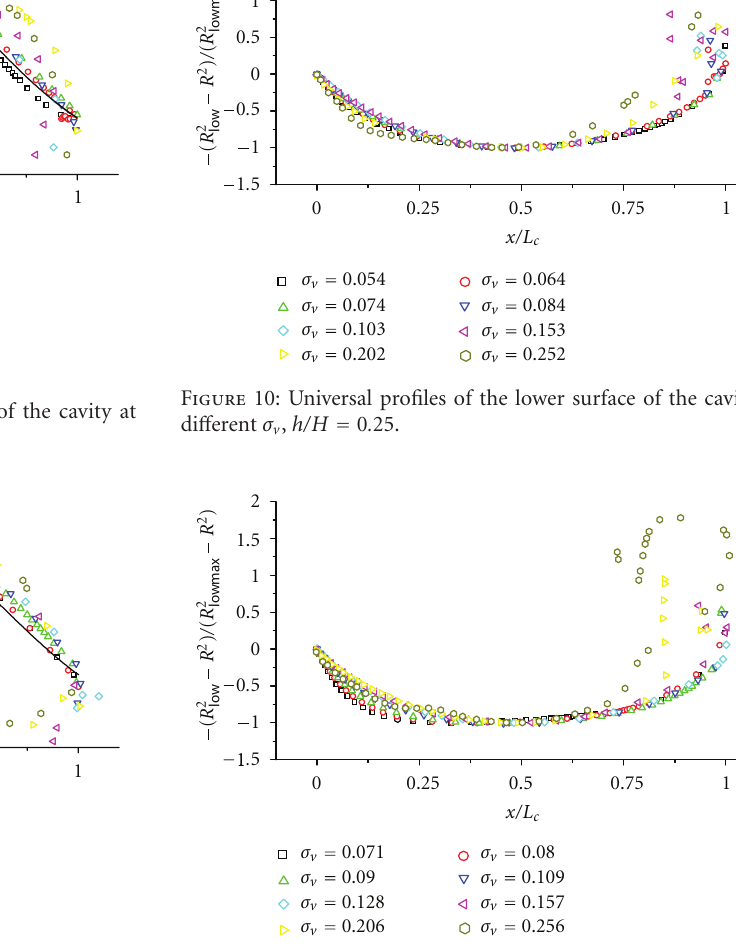
Figure 11: Universal profiles of the lower surface of the cavity at di ff erent σ v , h/H = 0 . 50.